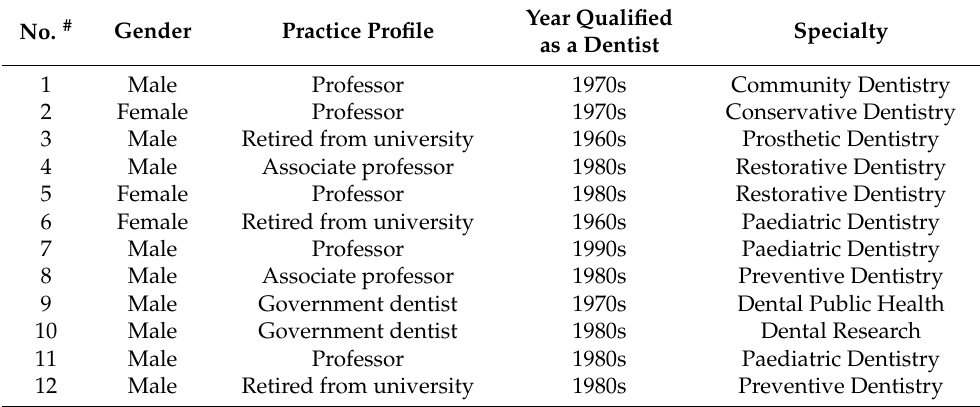
Table 6. Demographic information of the 12 interviewees for the qualitative